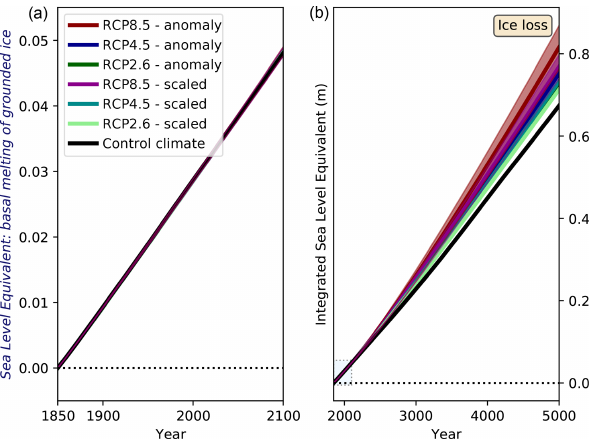
Figure E9. Cumulated basal melting of grounded ice as sea level equivalent. The results of the entire ensemble of ice sheet simulations are shown. The solid lines represent the ensemble averages for the applied precipitation anomalies and the temperature-scaled precipitation boundary conditions according to the legend. For the RCP8.5 scenario, the shading highlights the standard deviation (1 σ ) as a measure of the variability among the ice sheet ensemble members driven by various climate models (Table 1).